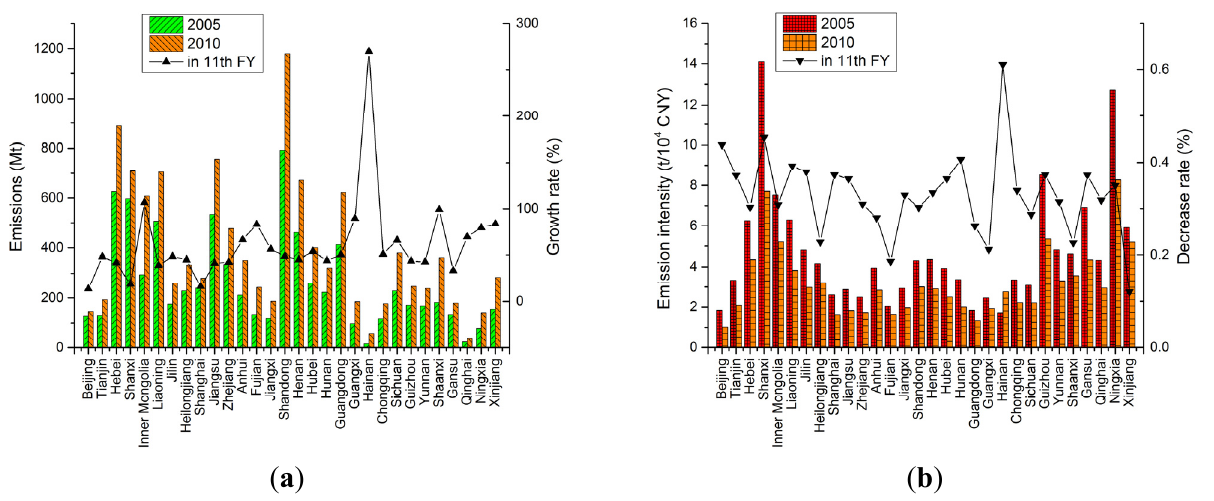
Figure 5. Temporal variation in provincial CO 2 emission ( a ) Variation of emissions in 2005–2010; and ( b ) Variation of emission intensity in